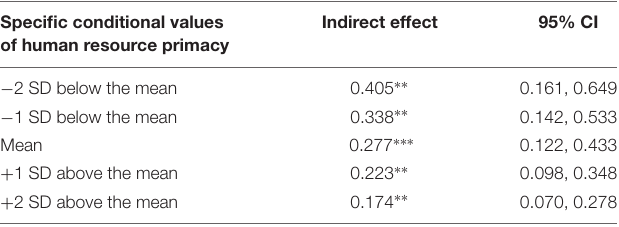
TABLE 4 | Moderated mediation effect of emotional dissonance on sickness absence at specific conditional values of human resource primacy. Specific conditional values of human resource